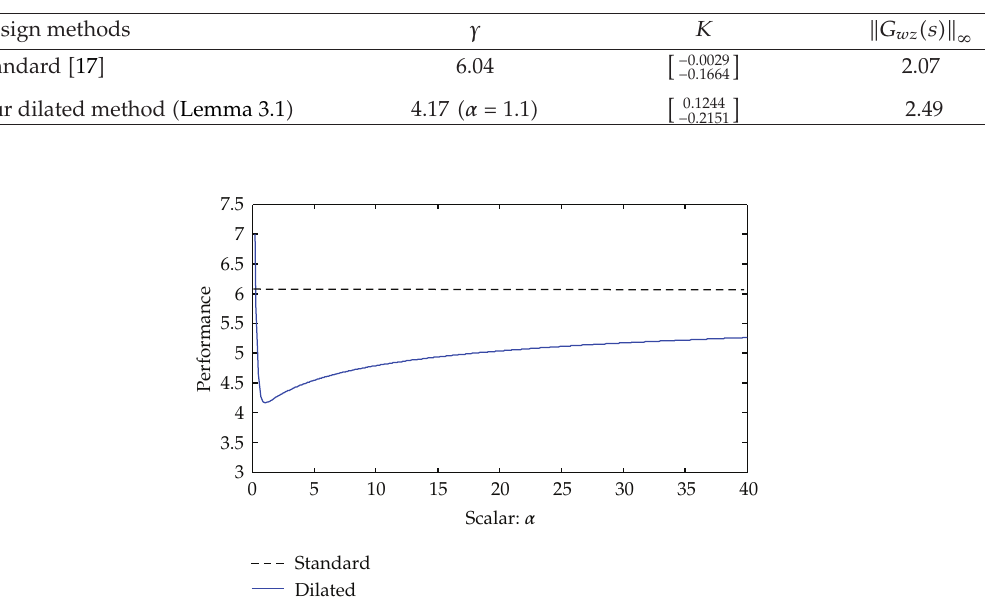
Table 1: Controller gain and the optimal H ∞ guaranteed cost.